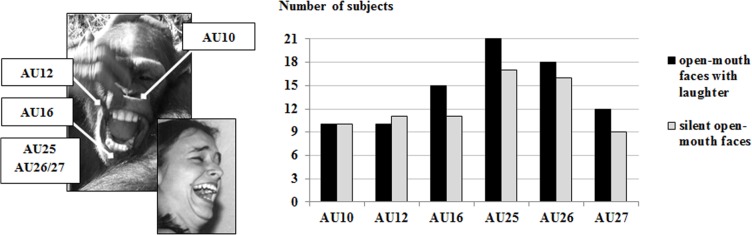
Action units of open-mouth faces.Total number of subjects producing the action units of open-mouth faces (with laughter and silently). AU10: Pulls the upper lip toward the nose, exposing the upper teeth; based on action of levator labii superioris; AU12: Pulls the lip corners upwards and backwards; based on action of zygomatic major; AU16: Depresses the lower lip, exposing the lower teeth; based on action of depressor labii inferioris; AU 25: Opens the lips; may involve action of different muscles (e.g., depressor labii inferioris, levator labii superioris, orbicularis oris); AU26 and AU27 are mutually exclusive. Prototypical open-mouth faces of chimpanzees consist of AU25 as well as AU26 and they may also include different combinations of AU10, AU12, and AU16 (for the action unit configurations, see Table 1). The individual in the picture has given informed consent.